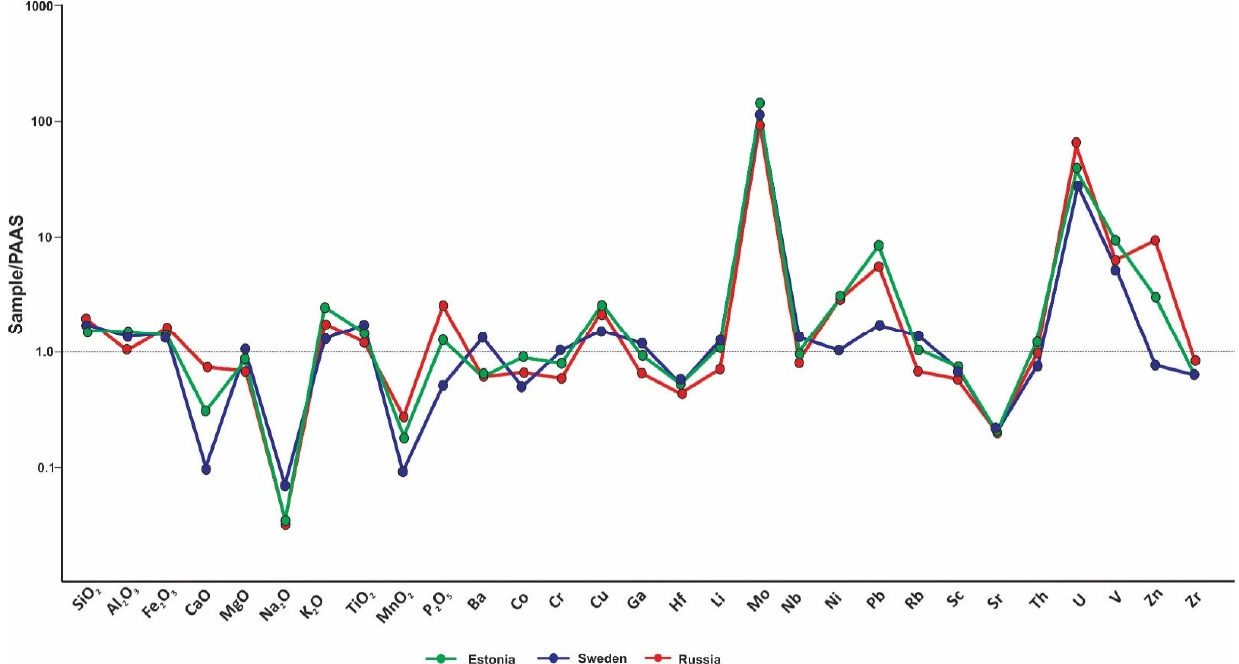
Figure 3. Major and trace element concentrations normalized against Post Archean Australian Shale [45]. The lines represent average elemental concentrations of drill cores from Estonia and Russia, and outcrops from Sweden.